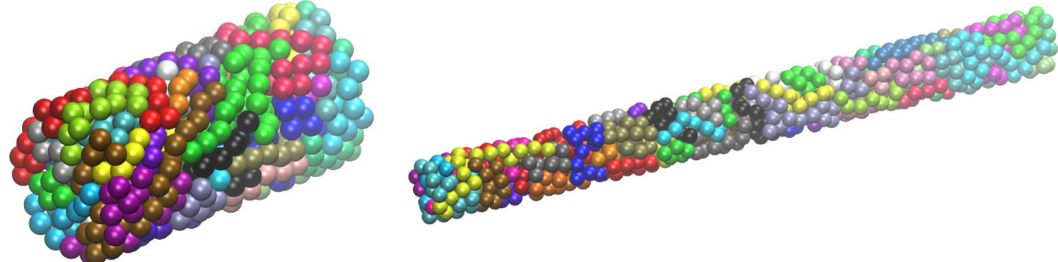
Figure 10. System snapshots of linear, fully flexible chains ( N ch = 60, N = 12, ϕ = 0.40) under cylindrical confinement with closed ends with a length-to-diameter ratio equal to 2 ( left panel ) and 10 ( right panel ). Monomers are colored according to the parent chain. Image created with the VMD visualization software [54]. Figure panels are also available as interactive, 3-D images in Supplementary